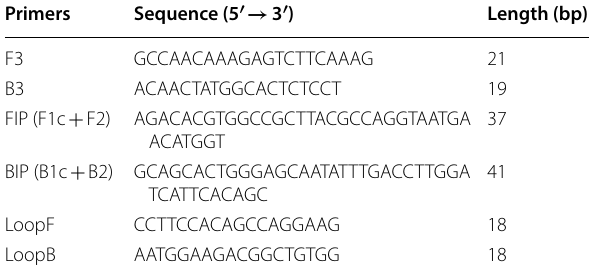
Table 3 The primer NS5-3 used for detection of Zika virus